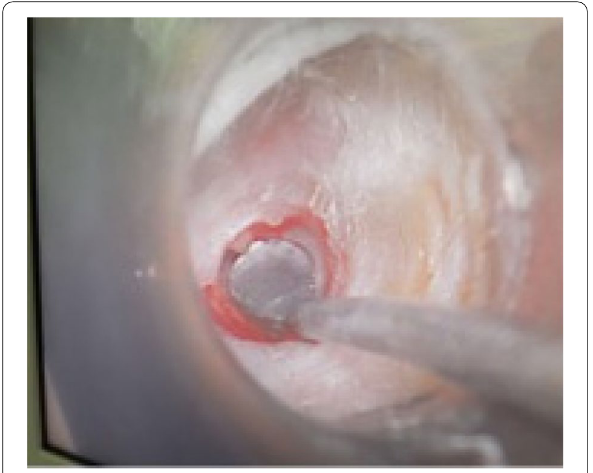
Fig. 1 Measuring the perforation with Rosen round